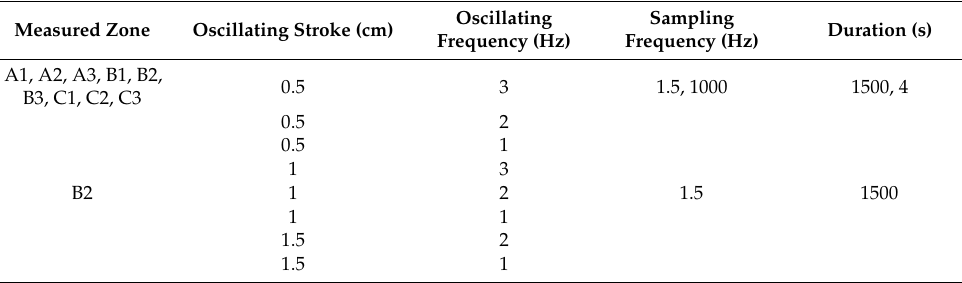
Table 2. Experimental set-up used to conduct the